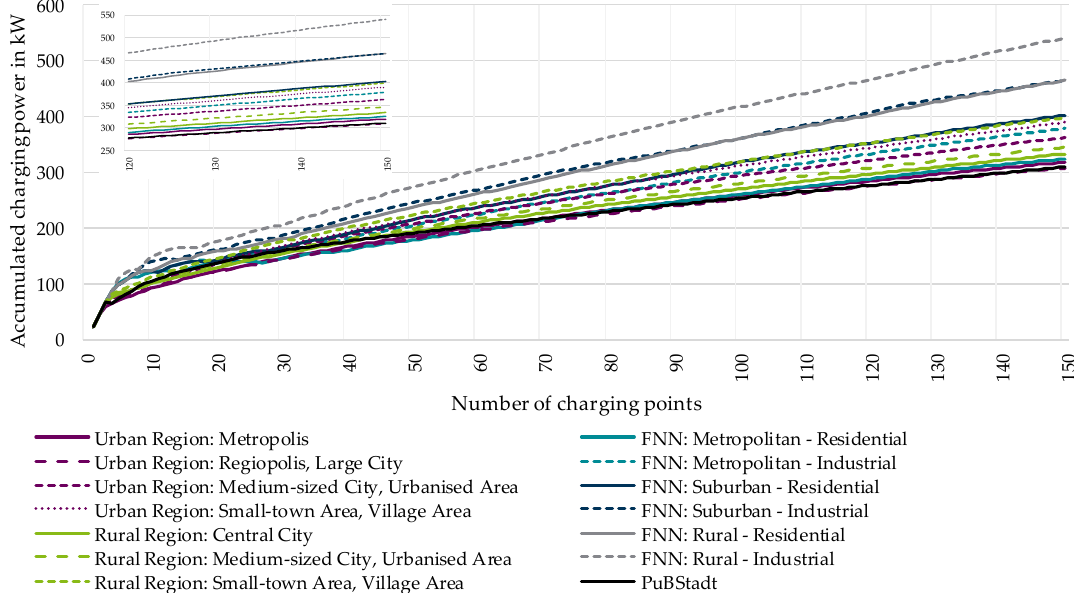
Figure 25. Demand factors (ordinate) for 11 kW charging power with seven different area types, six area types according to FNN and the results from PuBStadt for 150 charging points.